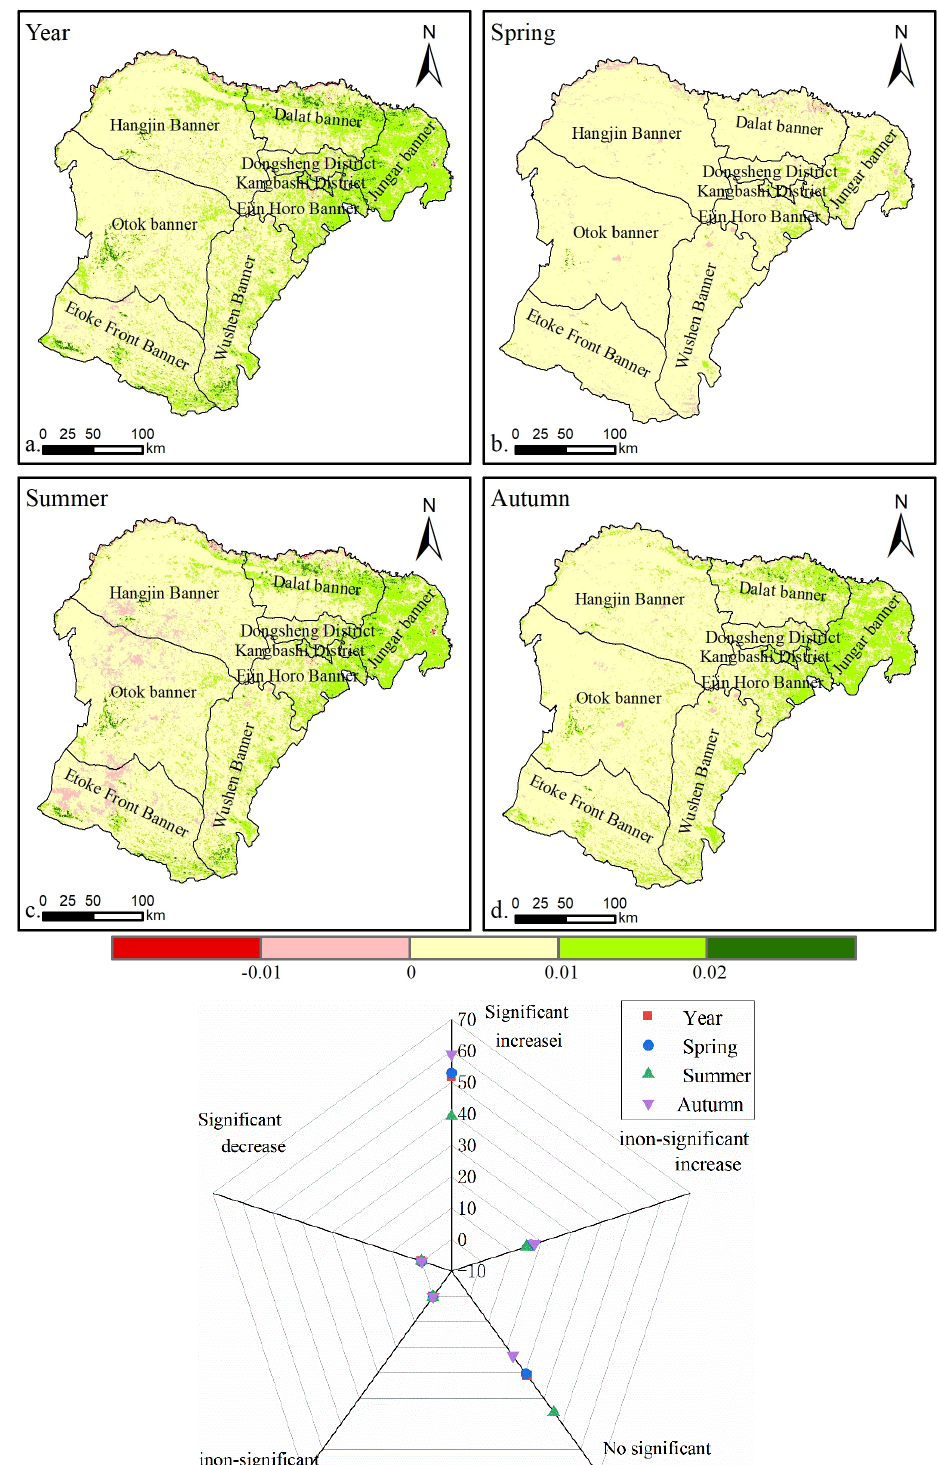
Figure 2. Variation trend and significance of vegetation NDVI in Ordos City. In summer, the mean value of vegetation NDVI in Ordos City is 0.319, with a small difference from the interannual mean value, the average annual increase rate is 0.0063/a, and the slope of vegetation NDVI in 94.52% of Ordos City (Figure 2c) is positive, the area where the improving trend is greater than 0.02 is much larger than that in spring. A total